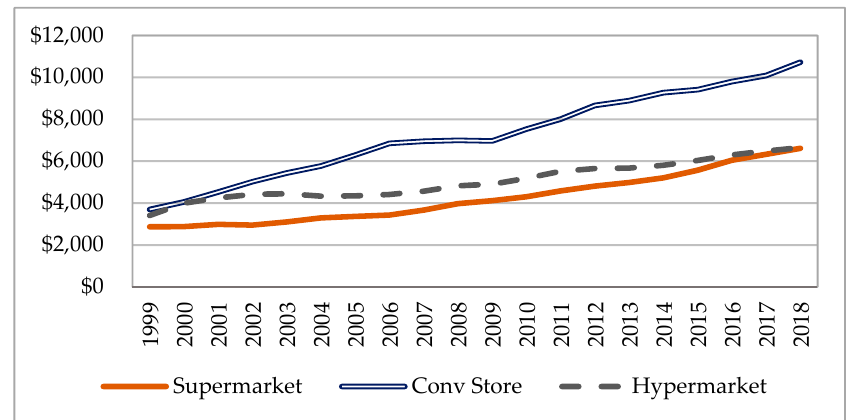
Figure 1. Sales volume of organized retailers (unit: million USD).